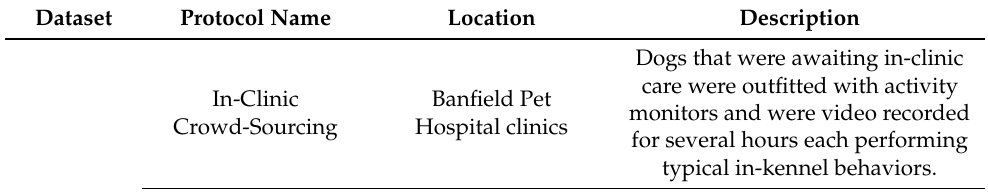
Table 1. Datasets derived from animal